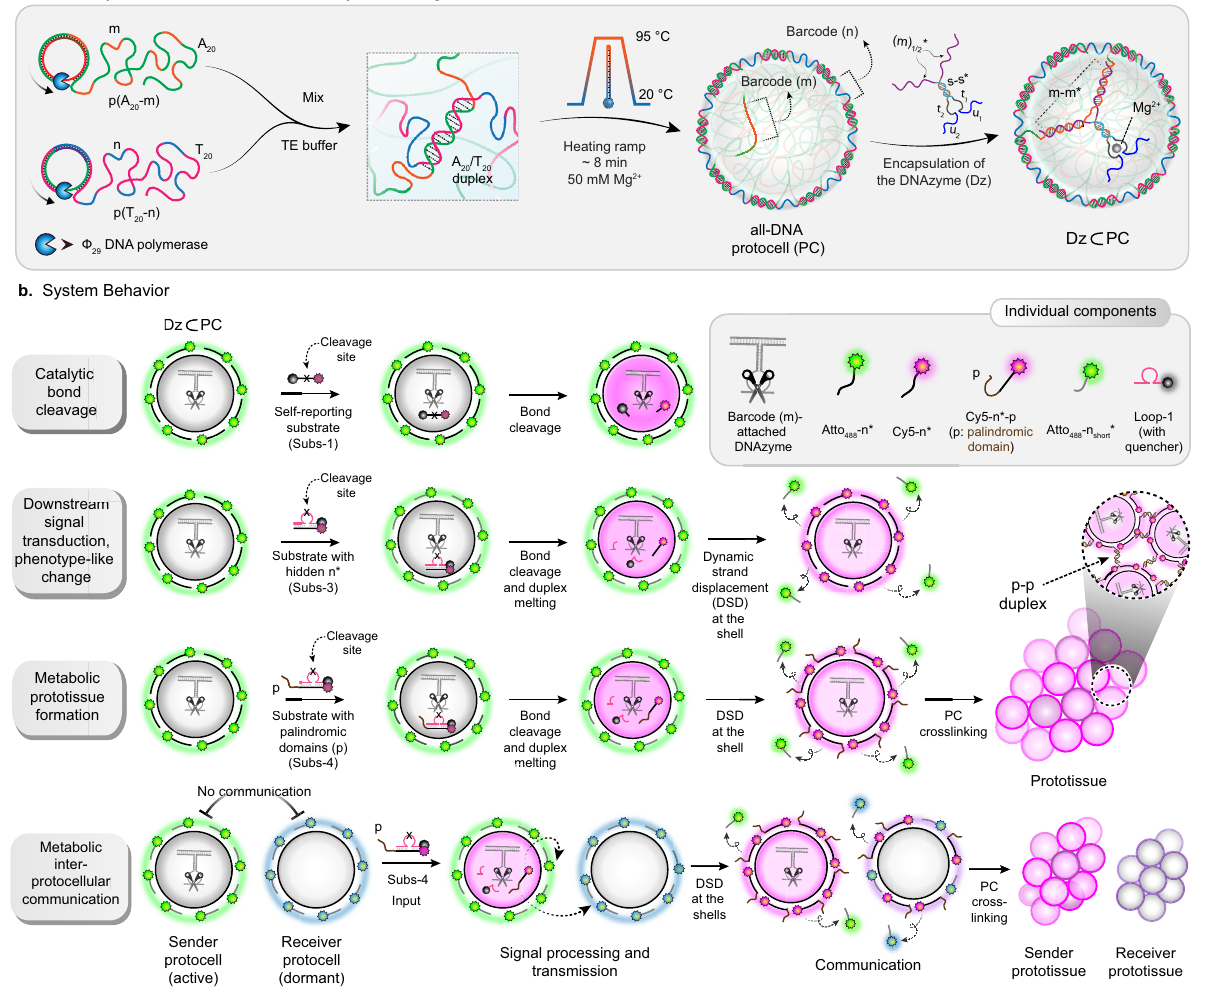
Fig. 1 Design, strategy, and system behavior of DNAzyme-catalyzed signal conversation, downstream functional adaptation inside all-DNA PCs, metabolic prototissue formation, and interprotocellular communication. a Synthesis of sequence-speci fi c two multiblock ssDNA polymers via rolling circle ampli fi cation (RCA). A buffered mixture of the ssDNA polymers is subjected to a fast-heating ramp (3 °C/min) in the presence of Mg 2 + (50 mM). Heat-induced phase-separation of p(A 20 -m) during heating and antagonistic duplex (A 20 -T 20 ) hybridization (at the coacervate surface) during the cooling step, resulting in the self-assembly of kinetically-trapped all-DNA PCs. The core and shell barcodes are denoted with m and n, respectively. The immobilization of DNAzymes (Dz) is achieved using duplex hybridization between m* residues of the Dz and the core barcodes (m). b The system properties are demonstrated in three different pathways. Firstly, a self-reporting substrate (Subs-1) carrying an RNA linkage is used to investigate the catalytic ef fi ciency of Dz in the con fi ned state, in which Cy5 fl uorescence (magenta color) increases upon cleaving the RNA linkage. Secondly, the downstream signal processing and phenotype-like change in PCs are demonstrated using a caged substrate (Subs-3). The Dz-catalyzed bond cleavage at the Loop-1 and subsequent release of Cy5-n* substitutes Atto 488 -n short *, changing the shell color from green to magenta. Thirdly, the metabolic prototissue formation is demonstrated by a similar loop substrate (Subs-4) bearing a palindromic (p) sequence, which gets exposed at the PC periphery after the intra- protocellular metabolic bond cleavage and a DSD reaction at the shell, leading to crosslinking of the PCs via p – p duplex formation. Lastly, the formation of sender and receiver prototissue formation via downstream interprotocellular signal transduction from active to dormant PCs is prompted by catalytic bond cleavage of Subs-4. All the strands are listed in Supplementary Table 2. (Cy5-n * -p) is used to prompt inter-PC communication by mul- were used purposefully to characterize the intra-protocellular tivalent binding scenarios. catalysis and to optimize the sequences for the next step. The Firstly, to investigate the catalytic activity of the Dz inside and stoichiometric ratio of Subs-1 to Dz is fi xed at 2.5 for comparing outside the PCs, we used a self-reporting substrate (Subs-1) with the catalyst activity. In more detail, Subs-1 binds to the u 1 and u 2 an RNA linkage and a FRET pair (Cy5 and a black hole quencher residues of the Dz, but after cleavage, the two parts of the initial ssDNA signal melt away due to the low melting temperature (BHQ)) covalently attached at both ends. Upon Dz-catalyzed ( T m = ~20 °C) of each individual half. The corresponding fl uor- breaking of the RNA bond in Subs-1, Cy5, and BHQ are sepa- escence traces show a 2-fold more ef fi cient Dz-catalyzed bond rated (Fig. 2a), giving rise to the enhancement of fl uorescence cleavage (DCBC) in the PC (~62% turnover of Subs-1) as com- intensity (represented in magenta color). Spectro fl uorometric (for pared to the solution (~35% turnover of Subs-1). The higher investigating catalytic ef fi ciency), cytometric (for statistical ana- activity of the DNAzyme inside the PC can be addressed by the lysis), and microscopic (for real-time visualization) techniques NATURE COMMUNICATIONS| (2022) 13:3968